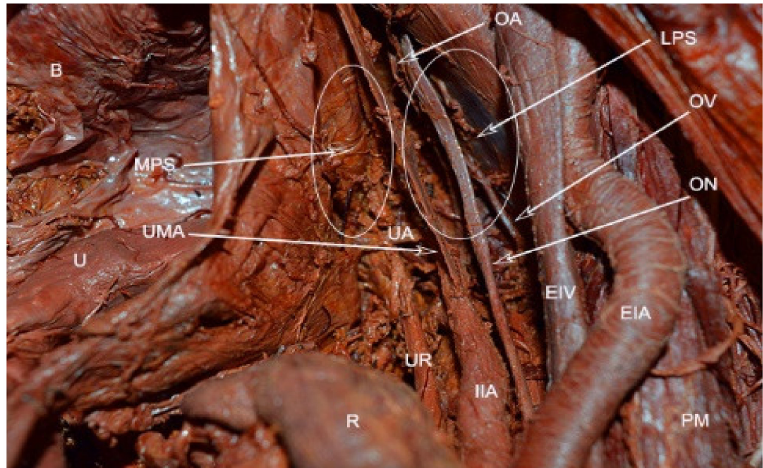
Figure 2. Paravesical space—embalmed cadaver (right side of the pelvis). The anterior leaf of the broad ligament is dissected and stretched laterally. MPS—medial paravesical space; LPS—lateral paravesical space; OA—obturator artery; OV—obturator vein; ON—obturator nerve; UA—uterine artery; UMA—obliterated umbilical artery; UR—ureter; EIV—external iliac vein; EIA—external iliac artery; PM—psoas muscle; IIA—internal iliac artery; R—rectum; U—uterus; B—bladder.